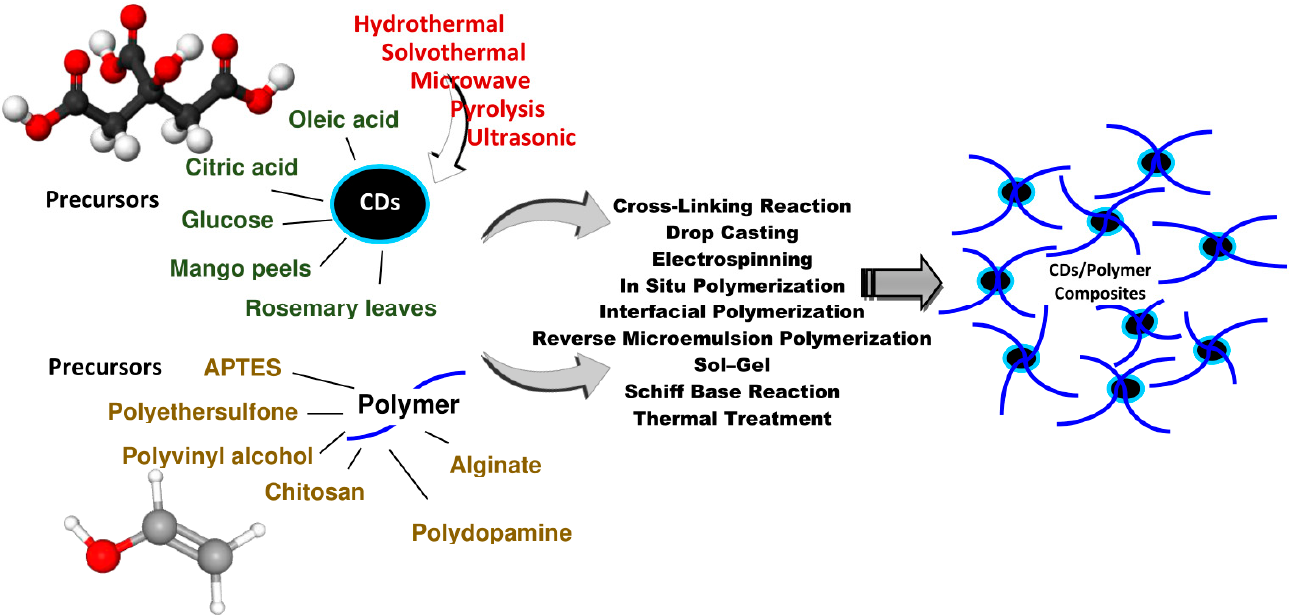
Figure 1. CD precursors, polymer precursors, and preparation methods for CD/polymer composites. The chemical structures of citric acid and polyvinyl alcohol, as the most used precursors for CD/polymer composites, are included.